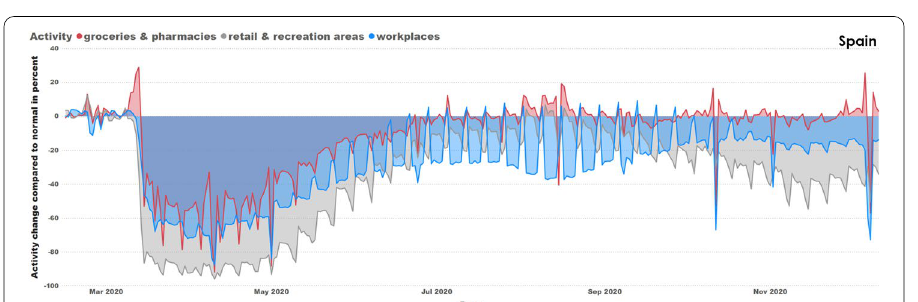
Fig. 15 Minimal but steady reduction of